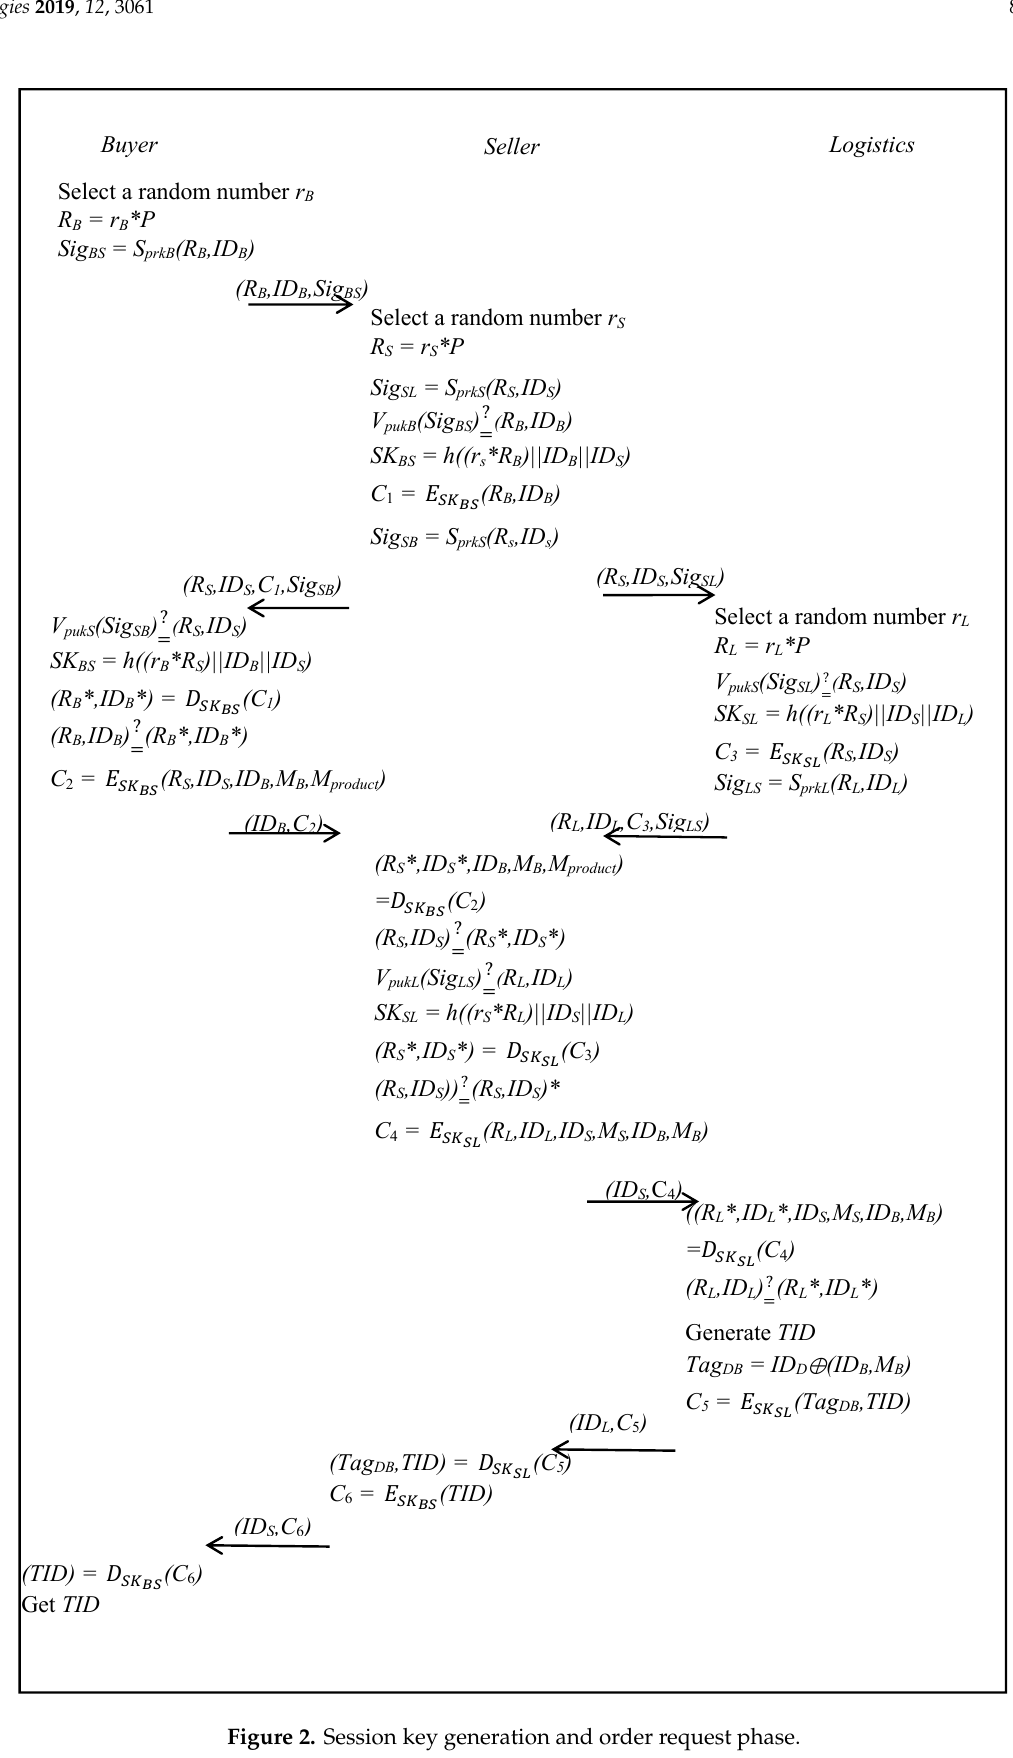
Figure 2. Session key generation and order request phase.